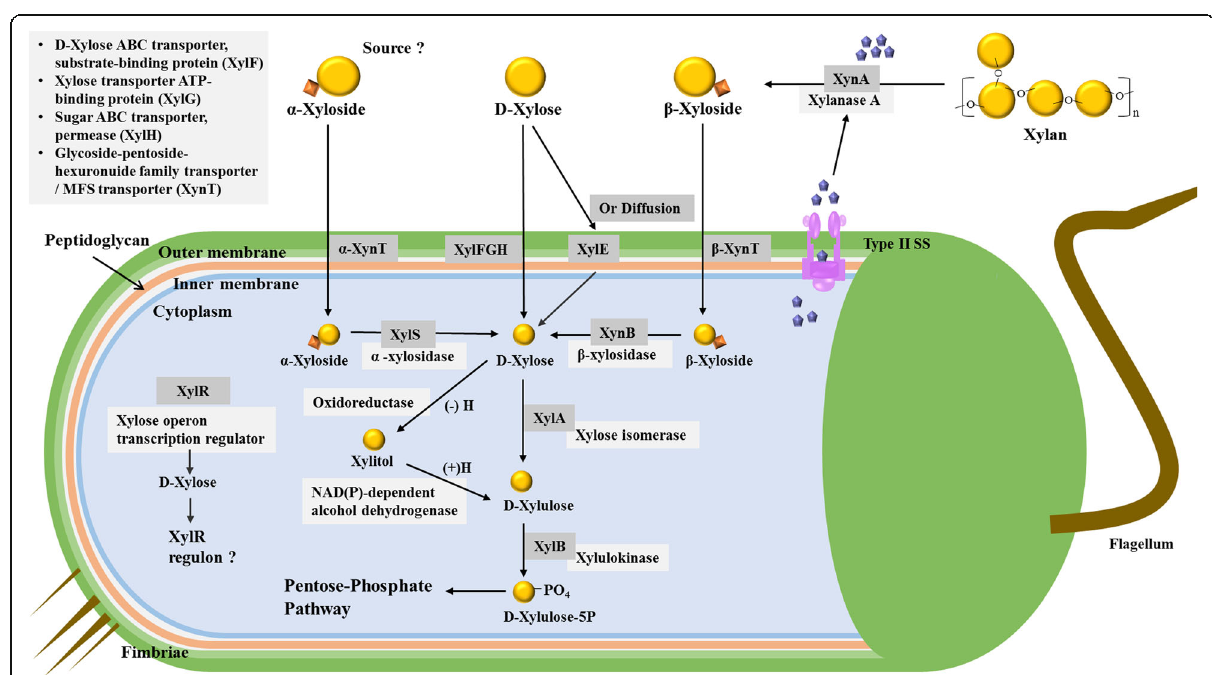
Fig. 4 Schematic representation of xylose utilization by C. sakazakii strain MOD1_Jor22. The proposed model for xylose utilization involves activation of the xylose regulon by the binding of D-xylose with XylR. It is thought that D-xylose enters the cell either through diffusion or transport via XylE or XylFGH. In addition, xylanase A (XynA) is secreted to the extracellular milieu through an unknown type 2 secretion component where it can digest xylan to β -xyloside which is then brought into the cell via a xyloside transporter (XynT, a putative β -xyloside transporter) where XynB ( β -xylosidase) converts it to D-xylose. Though unconfirmed, α - xyloside is thought to be transported into the cell where XylS ( α -xylosidase) converts to D- xylose. D- xylose then is converted to D-xylulose by XylA (xylose isomerase) and then converted to D-xylulose-5P by XylB (xylulokinase). This physiological pathway is identical to that of E. coli . Similar to that of E. coli , Cronobacter also have anaerobic metabolic pathway where D- xylose is converted to xylitol by oxidoreductase and then converted to D-xyloulose using NAD(P)-dependent alcohol dehydrogenase. D-xylulose-5P is then shunted into pentose- phosphate